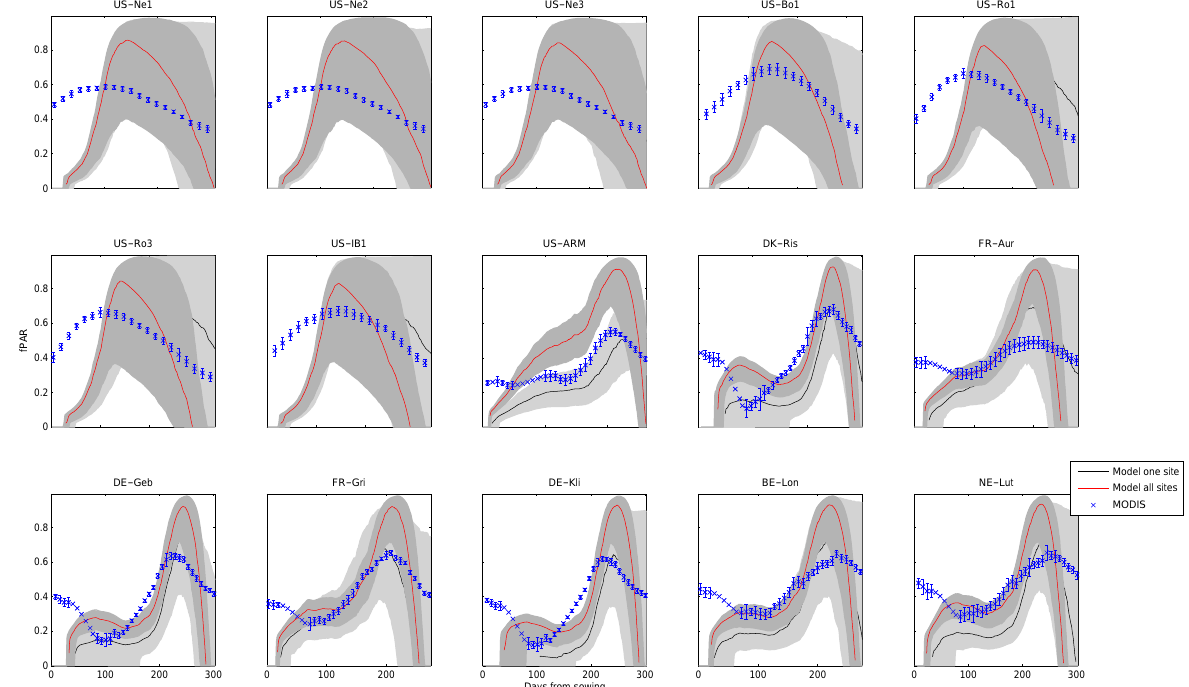
Figure A2. fAPAR predictions for 1 year for all sites fitted using all available data at each individual site and at all sites together. Grey shaded areas represent 95% confidence intervals drawn from the posterior